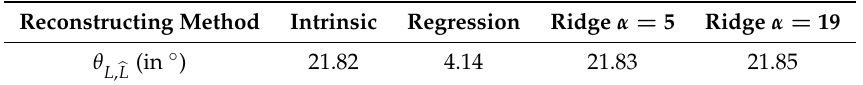
Table 2. Angular error between reference radiance spectrum and reconstructed spectra (the lowest, the